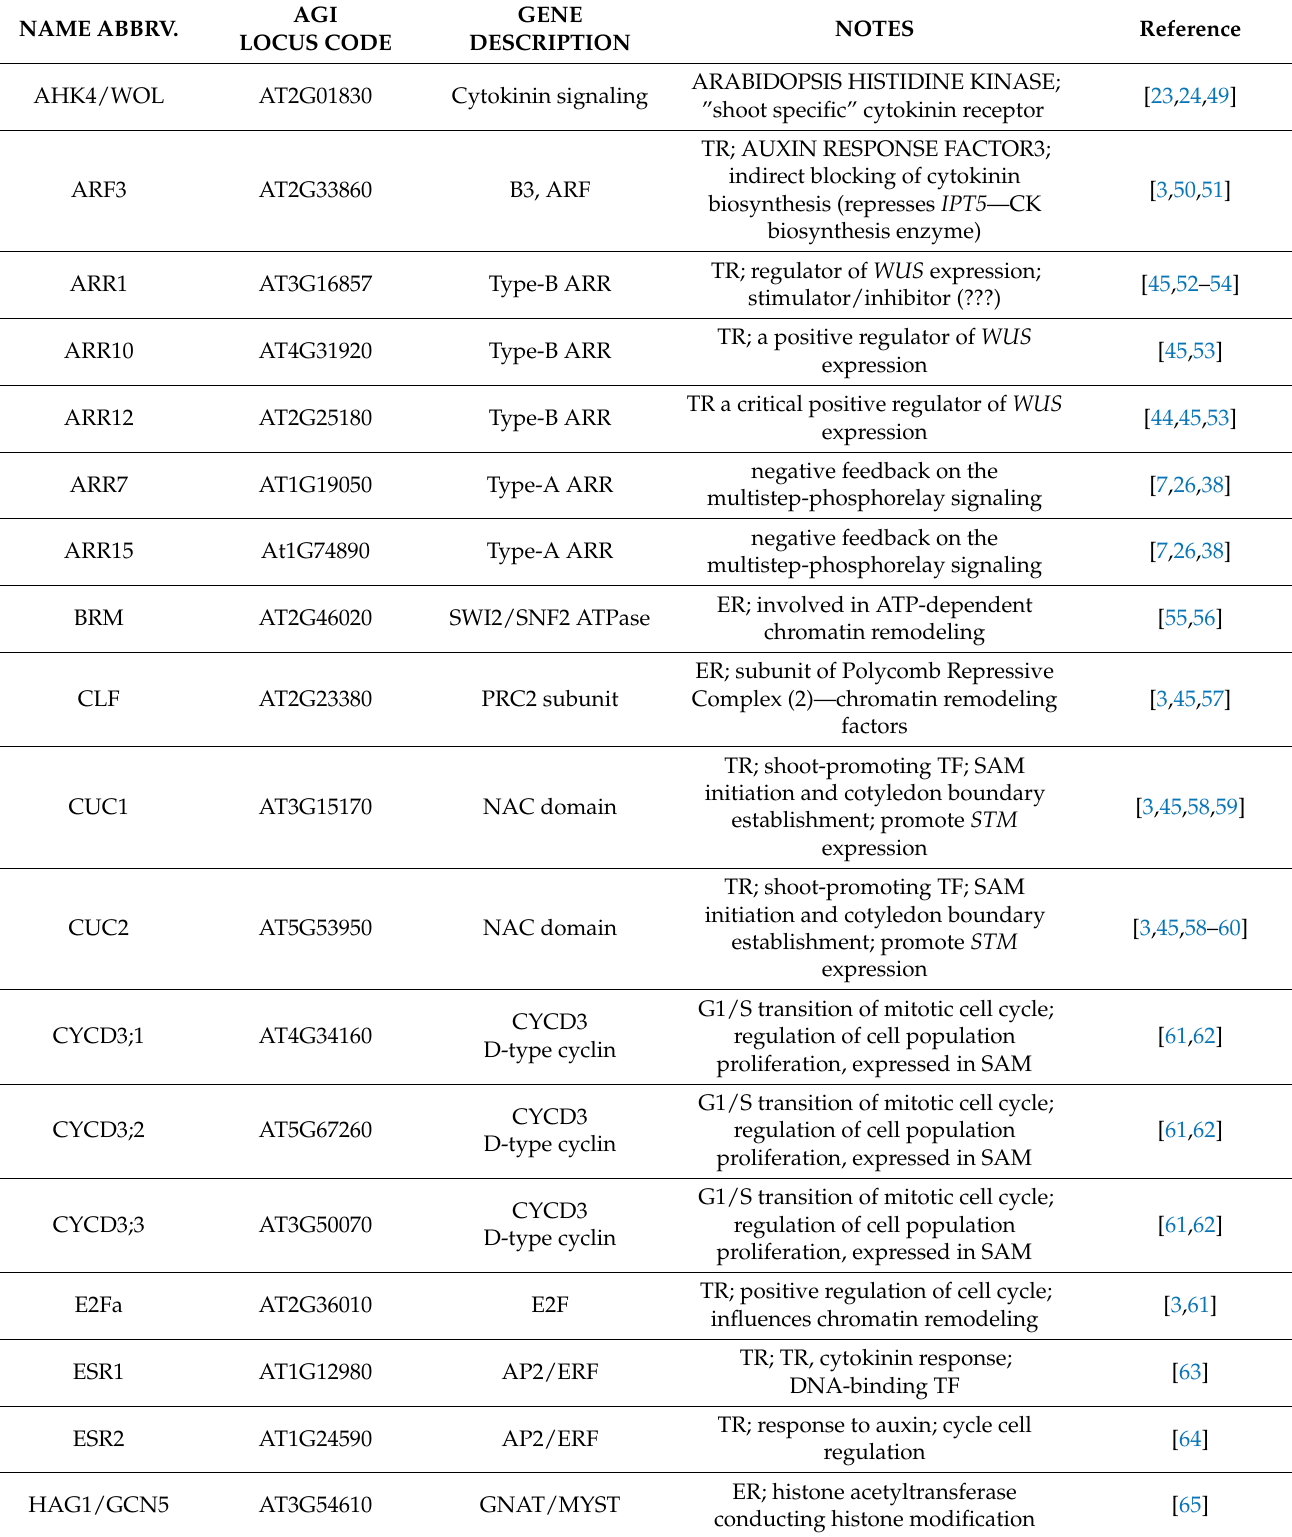
Table 1. Genes involved in shoot